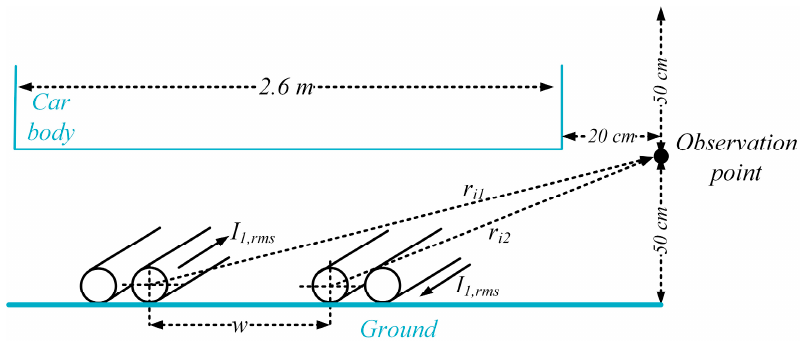
Figure 3. Reference geometry for the calculation of the radiated magnetic flux density.